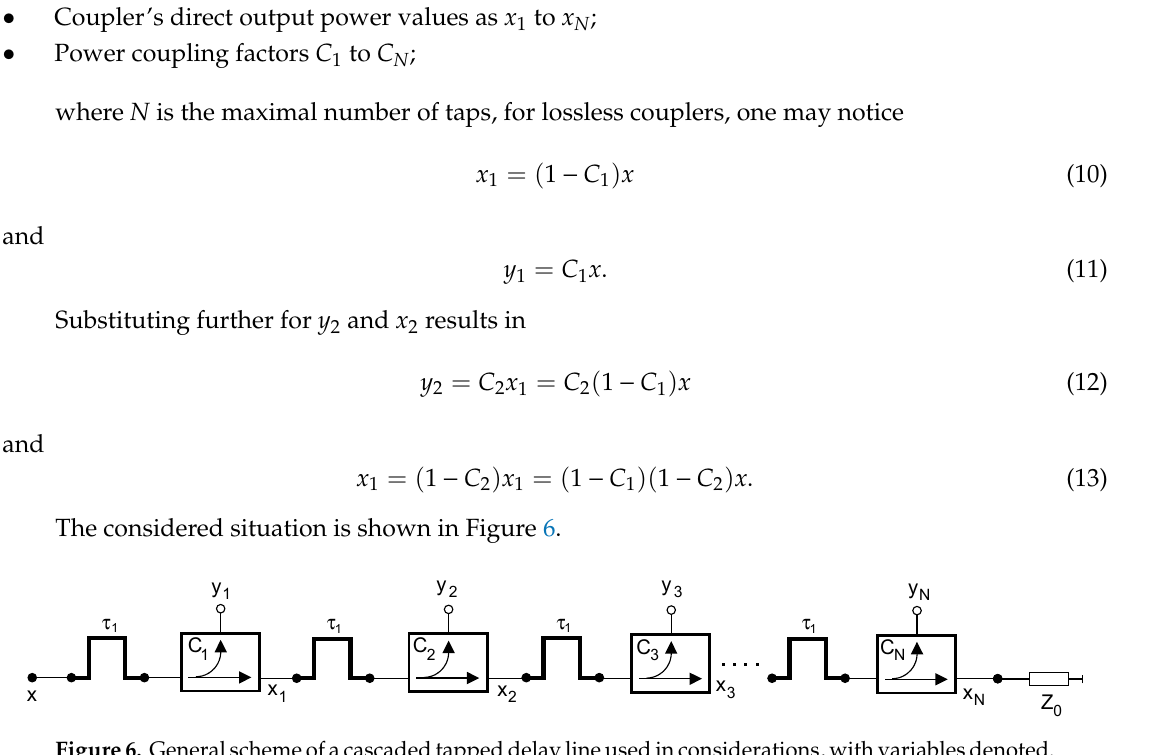
Figure 6. General scheme of a cascaded tapped delay line used in considerations, with variables denoted.